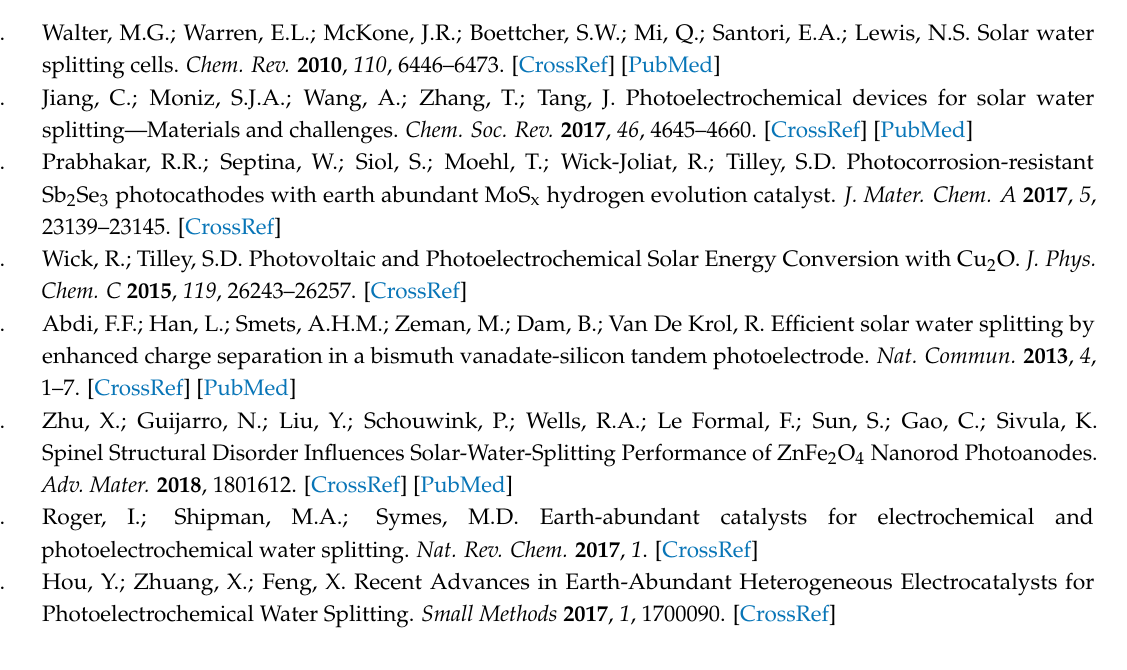
Figure S1: IR spectrum of meso-TiO 2 support, Figure S2: Raw IR spectra of Ru–Cl with increasing ALD layer thickness, Figure S3: Ru–Cl IR spectra after baseline correction in the relevant range, Figure S4: IR spectra of Ru–Cl after NaCN treatment, with varying ALD-layer thickness, Figure S5: UV-Vis spectra before ALD, Figure S6: UV-Vis spectra after ALD, Figure S7: XPS spectra before and after ALD deposition, Figure S8: Full CV scans, Figure S9: Chronoamperometric